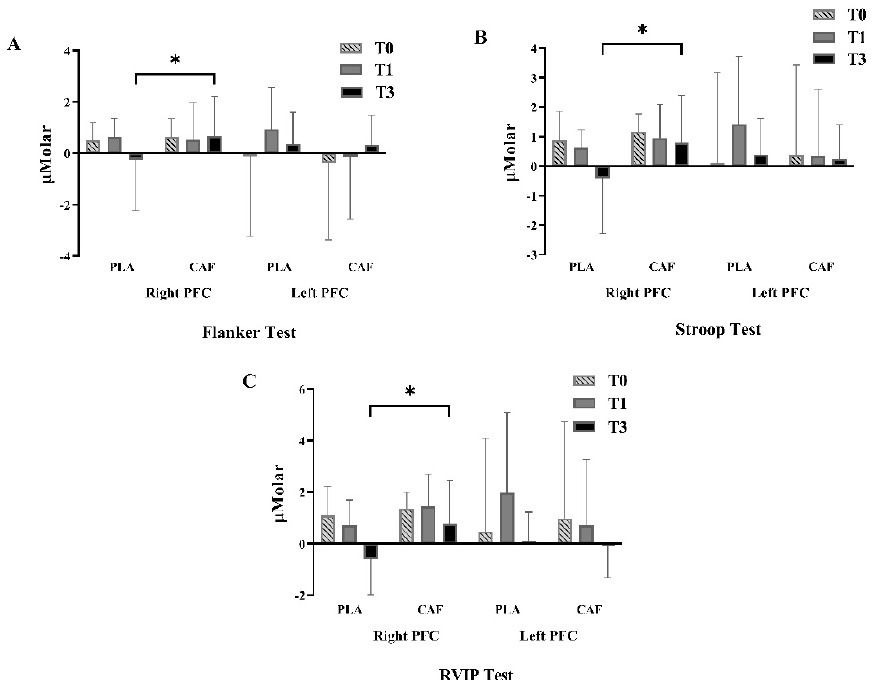
Figure 3. Results of fNIRS data in the left and right PFC at different time points. ( A ) Flank Test; ( B ) Stroop Test; ( C ) RVIP Test. PFC = Prefrontal cortex; PLA: Placebo trial; CAF: Caffeine trial; * Signif- icant difference between PLA trial and CAF trial.